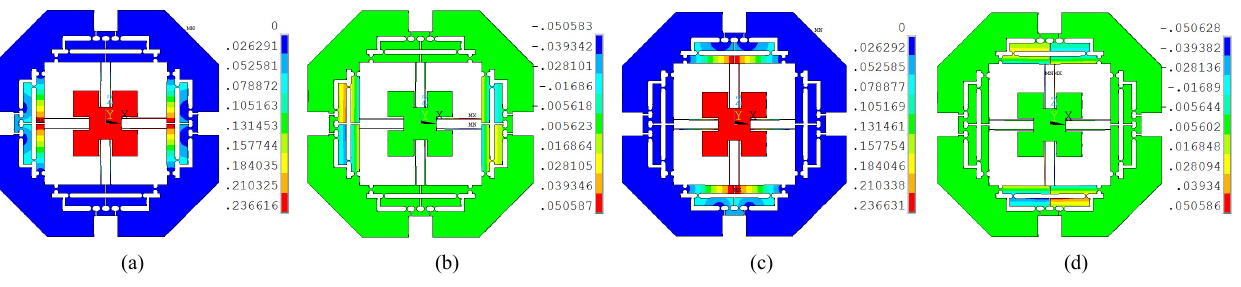
Figure 11. Output displacements and parasitic motions: (a) output displacement at x -axis; (b) parasitic motion at y -direction; (c) output displacement at y -axis; (d) parasitic motion at x -direction.